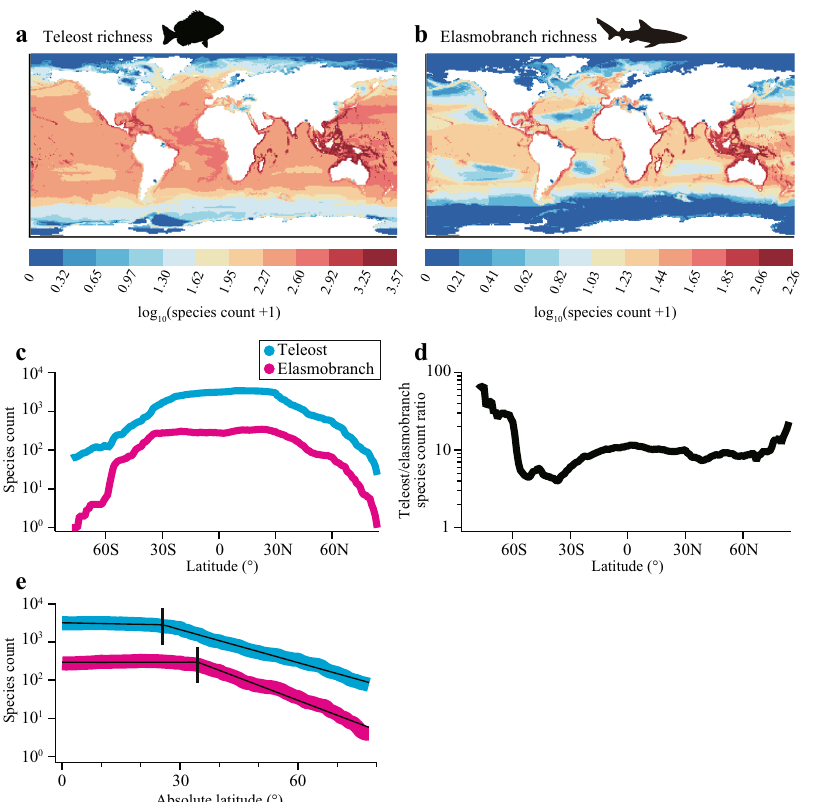
d Teleost/elasmobranch species count ratio (in a log scale) plotted against lati- tudes,showingthatitrisesathighlatitudes,especiallyinthesouthernhemisphere. e Species count (in a log scale) plotted against absolute latitude for teleosts and elasmobranchs, fi ttedwiththebroken-lineregressionmodel.Atlatitudesabovethe breakpoints (vertical bars), species count declines with latitude more rapidly in elasmobranchsthanteleosts.Sourcedatafor c – e areprovidedasaSourceData fi